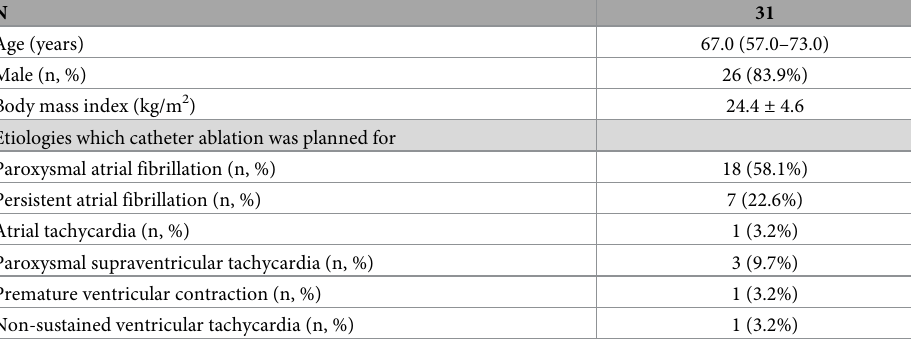
Table 1. Baseline characteristics of the study